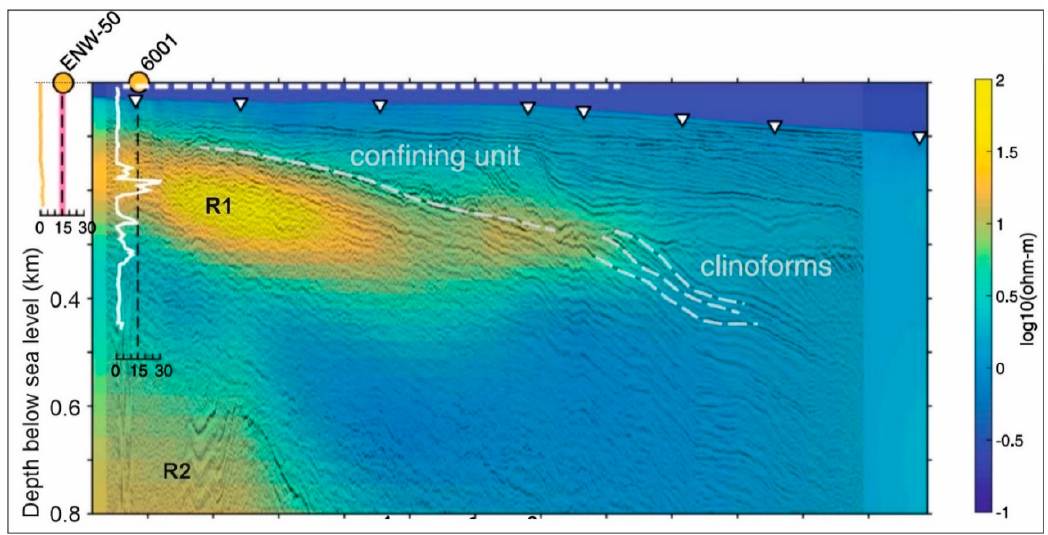
Figure 9. Resistivity models obtained from jointly inverting surface-towed CSEM and seafloor MT data for the shore-to-shelf profiles of Martha’s Vineyard with seismic data. Shaded colors show high resistivity as yellow hues and low resistivity as blue hues. White triangles show seafloor MT receiver locations and dashed white lines show the extent of the surface-towed CSEM data used in the inversions. Co-located seismic reflection image as well as pore water salinity data are also shown. Salinity data are plotted as white lines on linear scales. Onshore well ENW-50 salinity data are plotted in yellow. Black dashed lines represent a salinity value of 15. Seismically imaged confining units and clinoform structures that influence groundwater distribution patterns are shown as labeled light grey dashed lines (modified from Reference [104]). Location of line in Figure 6A.